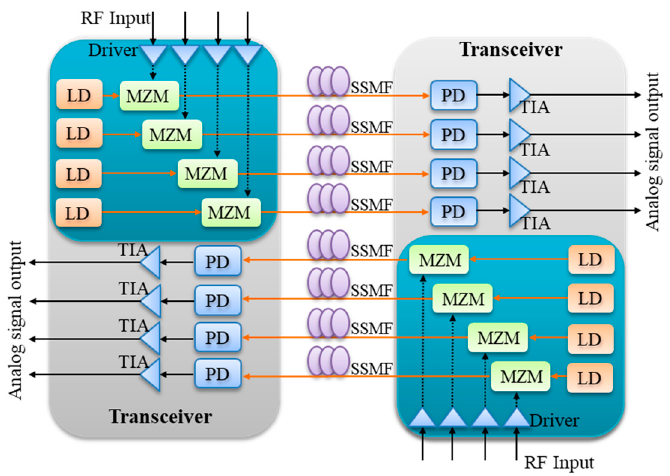
Figure 10. Block diagram of transceiver integration scheme based on direct detection. LD: laser diode; MZM: Mach-Zehnder modulator; RF: radio-frequency; SSMF: standard single mode fiber; TIA: trans-impedance amplifier; PD: photodetector.